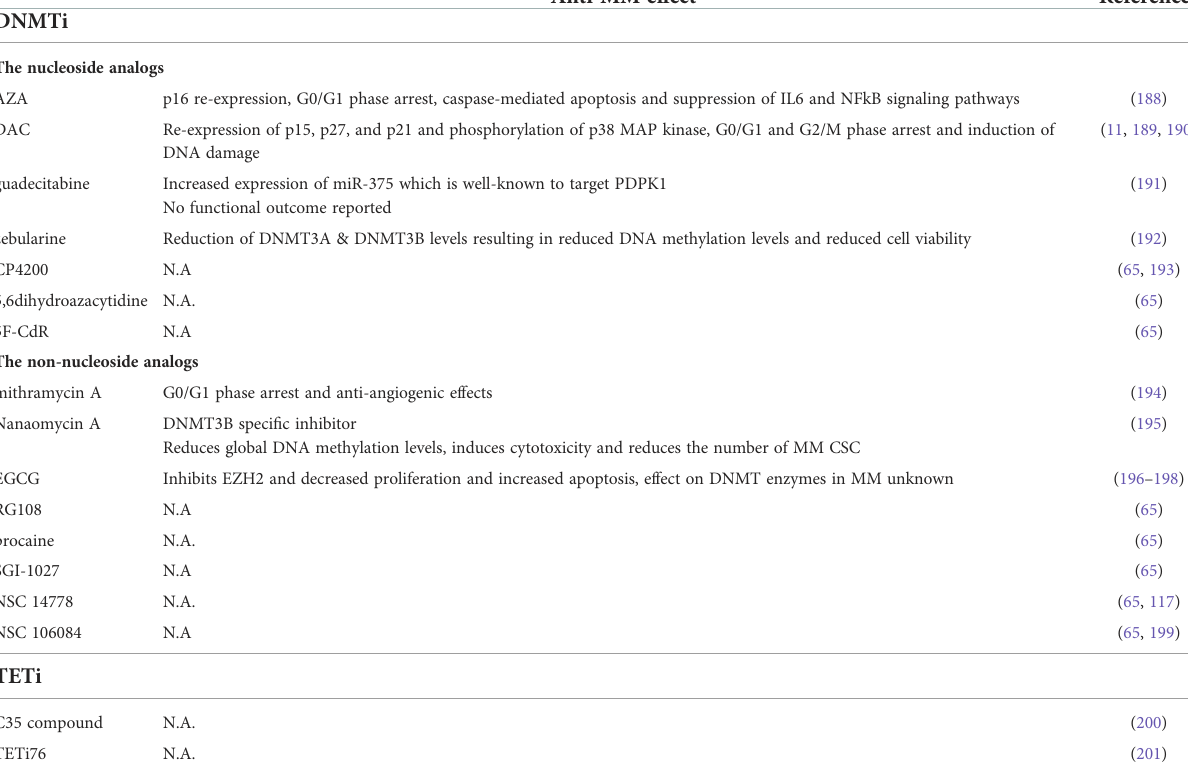
TABLE 4 Overview of the DNMTi and TETi in preclinical development in